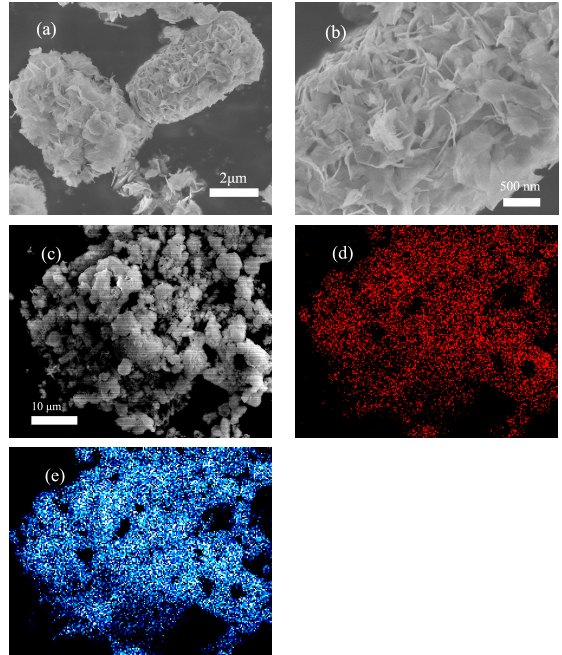
Figure 2. ( a , b ) Low magnification and higher magnification FESEM image of the BS-2# sample; ( c ) SEM-EDS elemental mapping of the the BS-2# sample; and the corresponding elemental mappings of ( d ) S and ( e ) Bi.